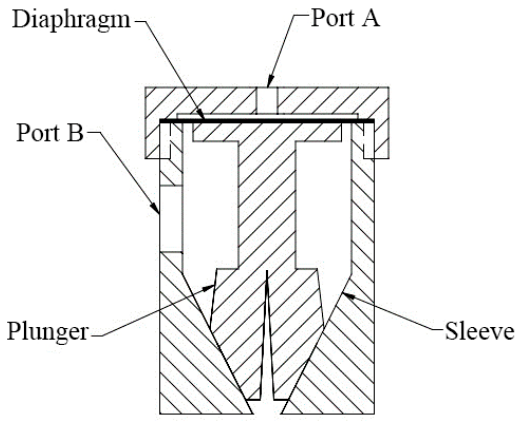
Figure 6. Schematic diagram of a variable nozzle. Port A: control liquid pressure, Port B: supply line pressure [76].